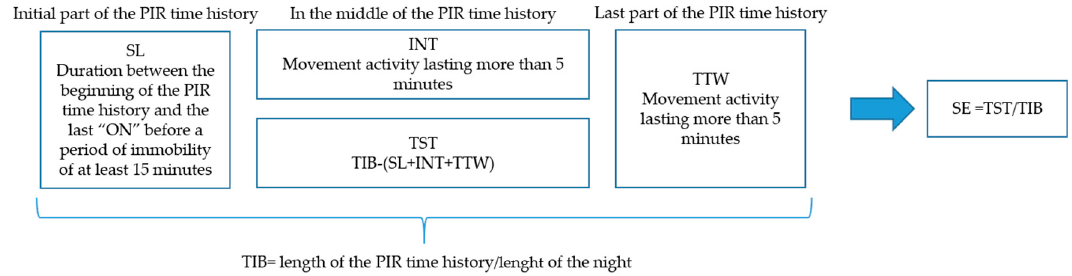
Figure 3. Sleep patterns extracted from the algorithm and the related method used to derive these parameters.